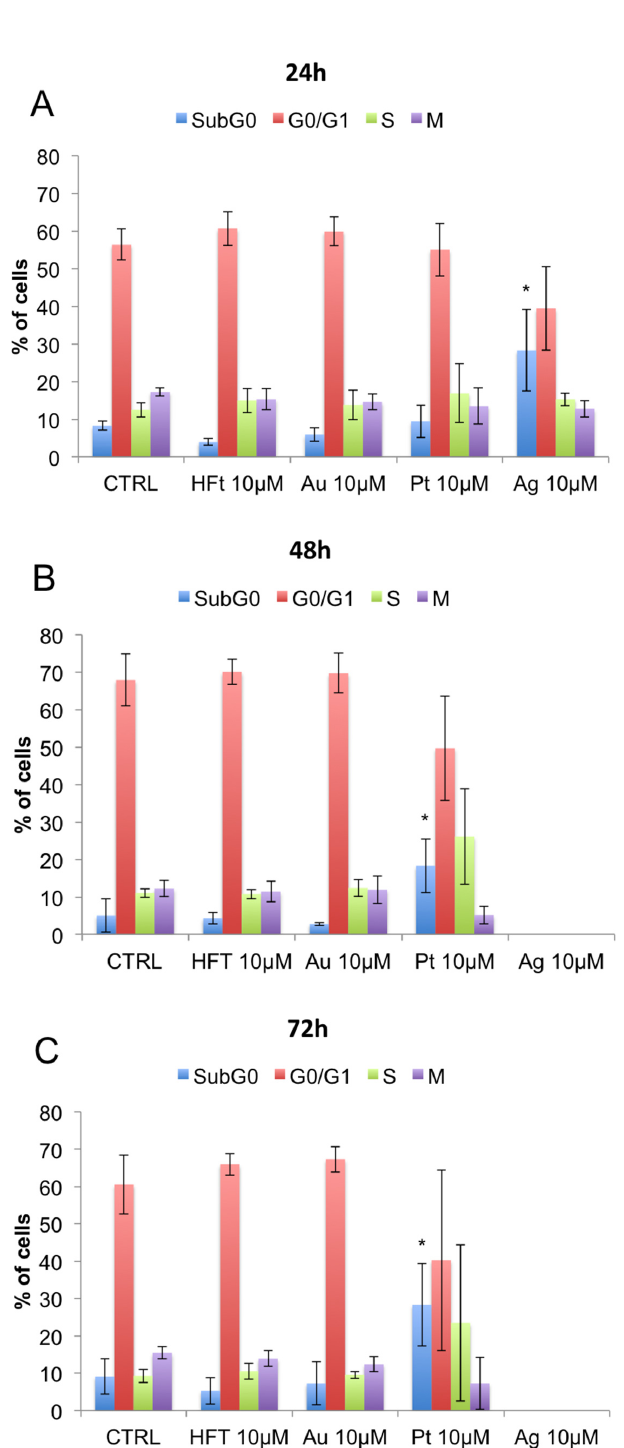
Figure 4. Cell cycle analysis by flow cytometry on SH-SY5Ycells upon HFt-based nanocarriers exposure, after staining with propidium iodide dye to evaluate cell cycle progression and apoptosis. ( A ) 24 h treatment; ( B ) 48 h treatment; and ( C ) 72 h treatment. For each experiment, treatments with 10 µ M nanocarriers (NCs) (expressed as metal concentration) were assayed. The effects of no treatment (CTRL), treatment with HFt (CTRL), HFt-Ag, HFt-Au and HFt-cisPt are shown. Standard deviations are indicated. Statistical significance assessed by t -test; * p ( t -test) <